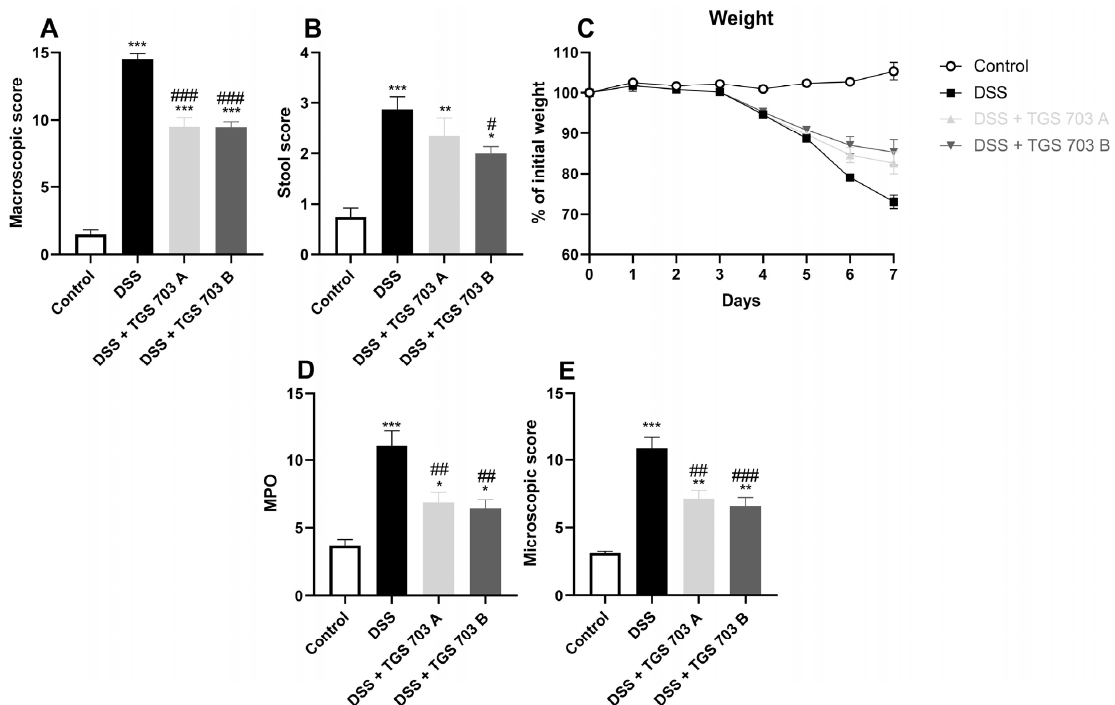
Figure 8. The effect of TGS 703 on colonic inflammation in a dextran sulphate sodium (DSS)-induced model of colitis: macroscopic score ( A ), stool score ( B ), myeloperoxidase activity ( D ), and microscopic score ( E ) for control, DSS-only treated mice, and mice with DSS-induced colitis treated with TGS 703 in two doses: 1.68 μ g/kg (TGS 703 0.1A) and 16.8 μ g/kg (TGS 703 1A). * p < 0.05, ** p < 0.01 and *** p < 0.001 as compared with the control mice; # p < 0.05, ## p < 0.01, ### p < 0.001 as compared with DSS-treated animals. ( C ) Presents changes in the weight of mice during the DSS-induced animal model of colitis.